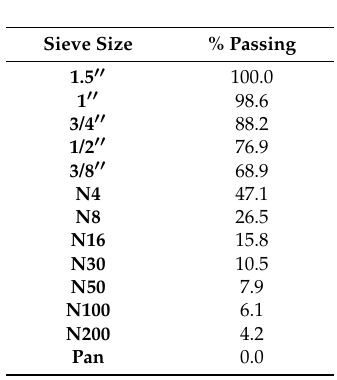
Table 3. Aggregate gradation used for asphalt mixture